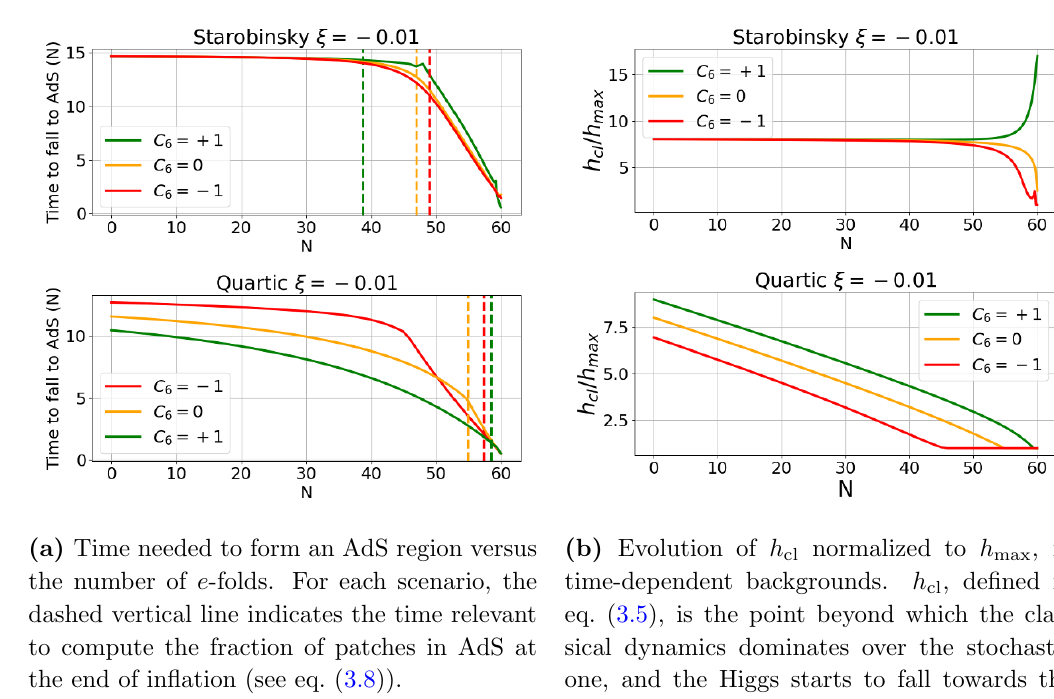
Figure 9. Time to form an AdS region starting from the \point of classicality" h cl